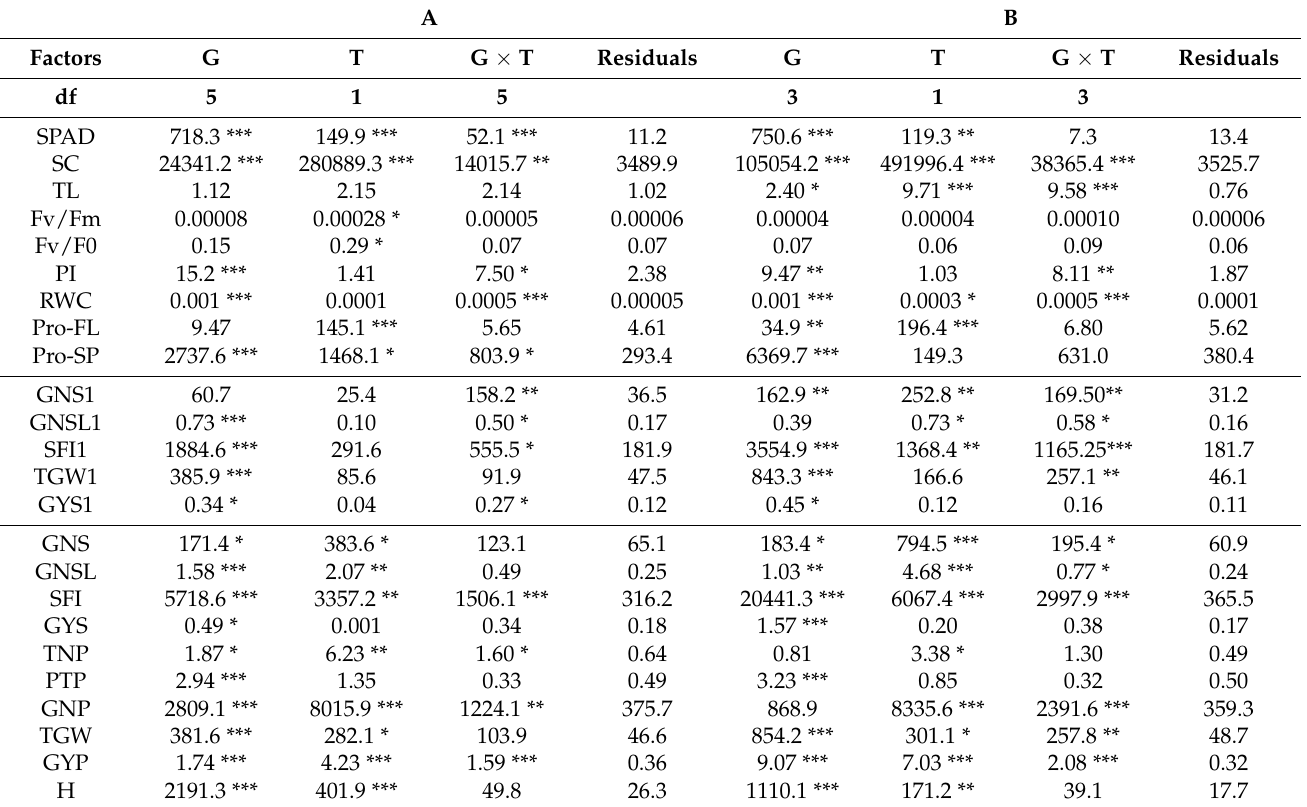
also proved to be noticeably superior (+82% and +44%, respectively; Table S2), while the Table 2. ANOVA mean squares for physiological, biochemical and yield-related traits measured under control and HS treatment: (A) comparison between alien segment carrier (NIRLs+) and non- carrier (NIRLs-) lines, and (B) comparison between NIRLs+ and cv. Margherita. *, **, and *** indicate significance at p < 0.05, p < 0.01 and p < 0.001 levels, respectively (df, degrees of freedom; G, genotype; T, treatment). For trait acronyms, see the Materials and Methods